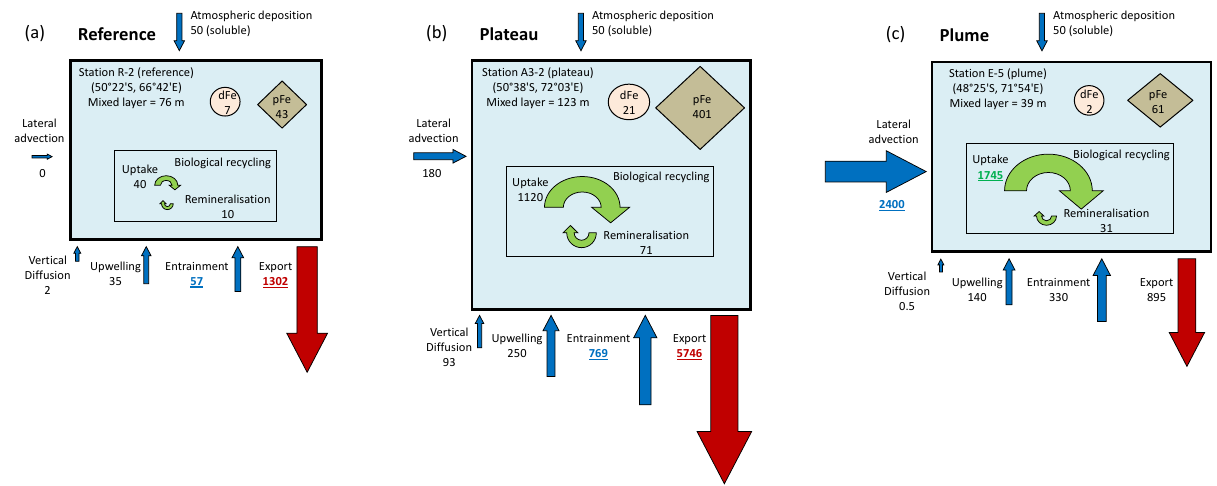
Figure 7. Biogeochemical iron budgets for the reference (R-2, a ), plateau (A3-2, b ) and plume (E-5, c ) stations. Iron pools are given in µmolm − 2 and iron fluxes in nmolm − 2 d − 1 . Iron sources are shown as blue arrows, sinks as red arrows and the green arrows indicate biological Fe cycling. The size of the arrows is roughly proportional to the magnitude of the Fe fluxes, with major fluxes shown as bold underlined